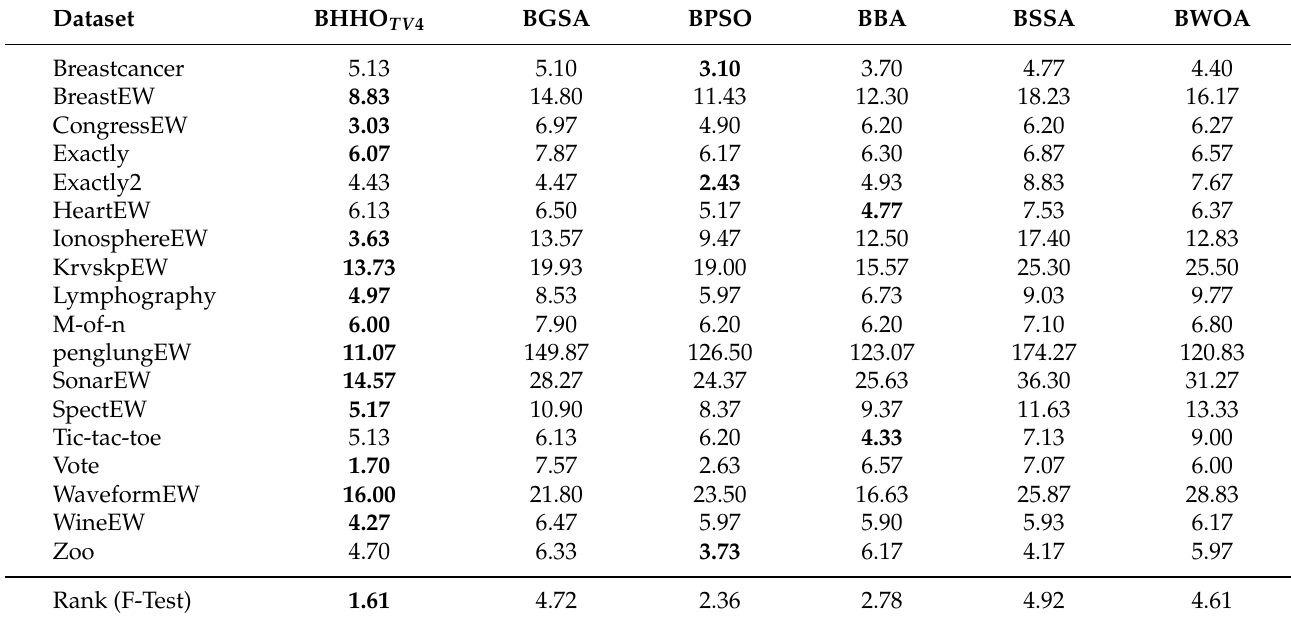
Table 9. Comparison of BHHO TV 4 versus other optimizers in terms of average selected